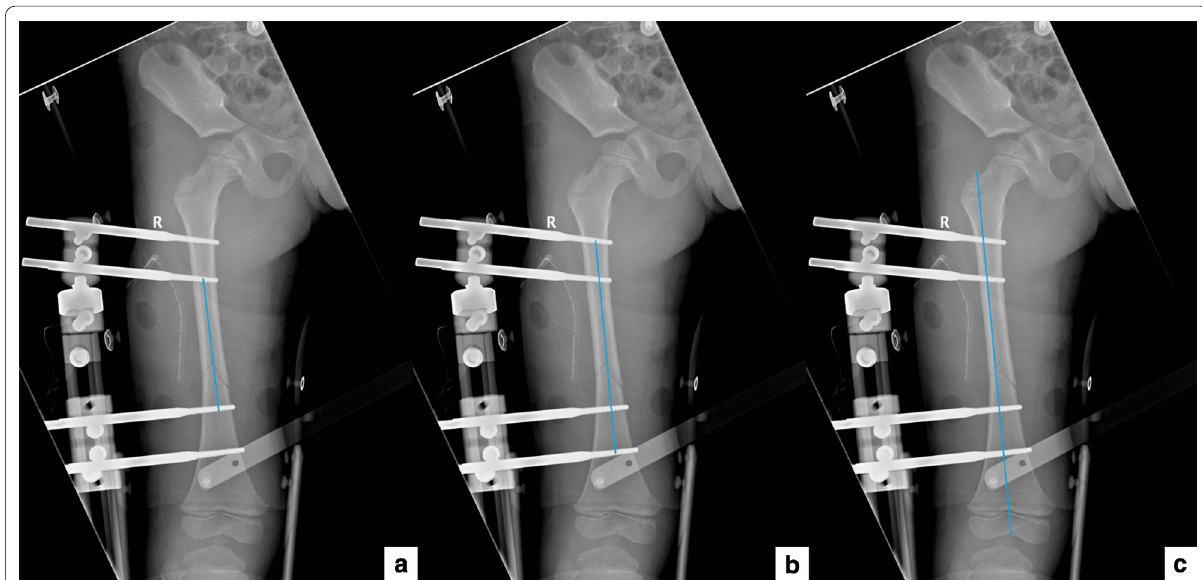
Fig. 1 A diagram of L1, L2, and L3. a L1, the length of femur fixed by two screws closest to the fracture line; b L2, the length of femur fixed by the two screws farthest from the fracture line, c L3, the total length from the greater trochanter to the distal end of femur